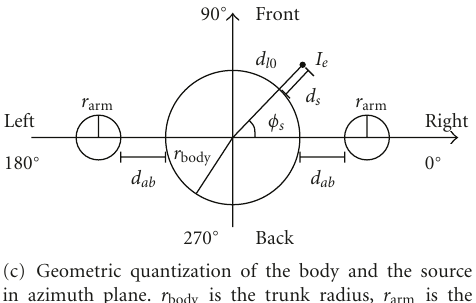
(c) Geometric quantization of the body and the source in azimuth plane. r body is the trunk radius, r arm is the arm radius, d ab is the distance between the arm and the trunk, and d s is the distance from the source to the trunk